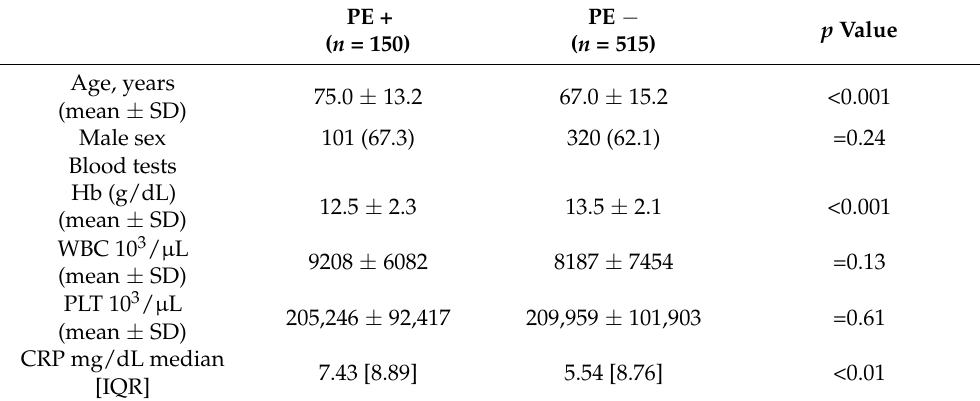
Table 1. Characteristics of the